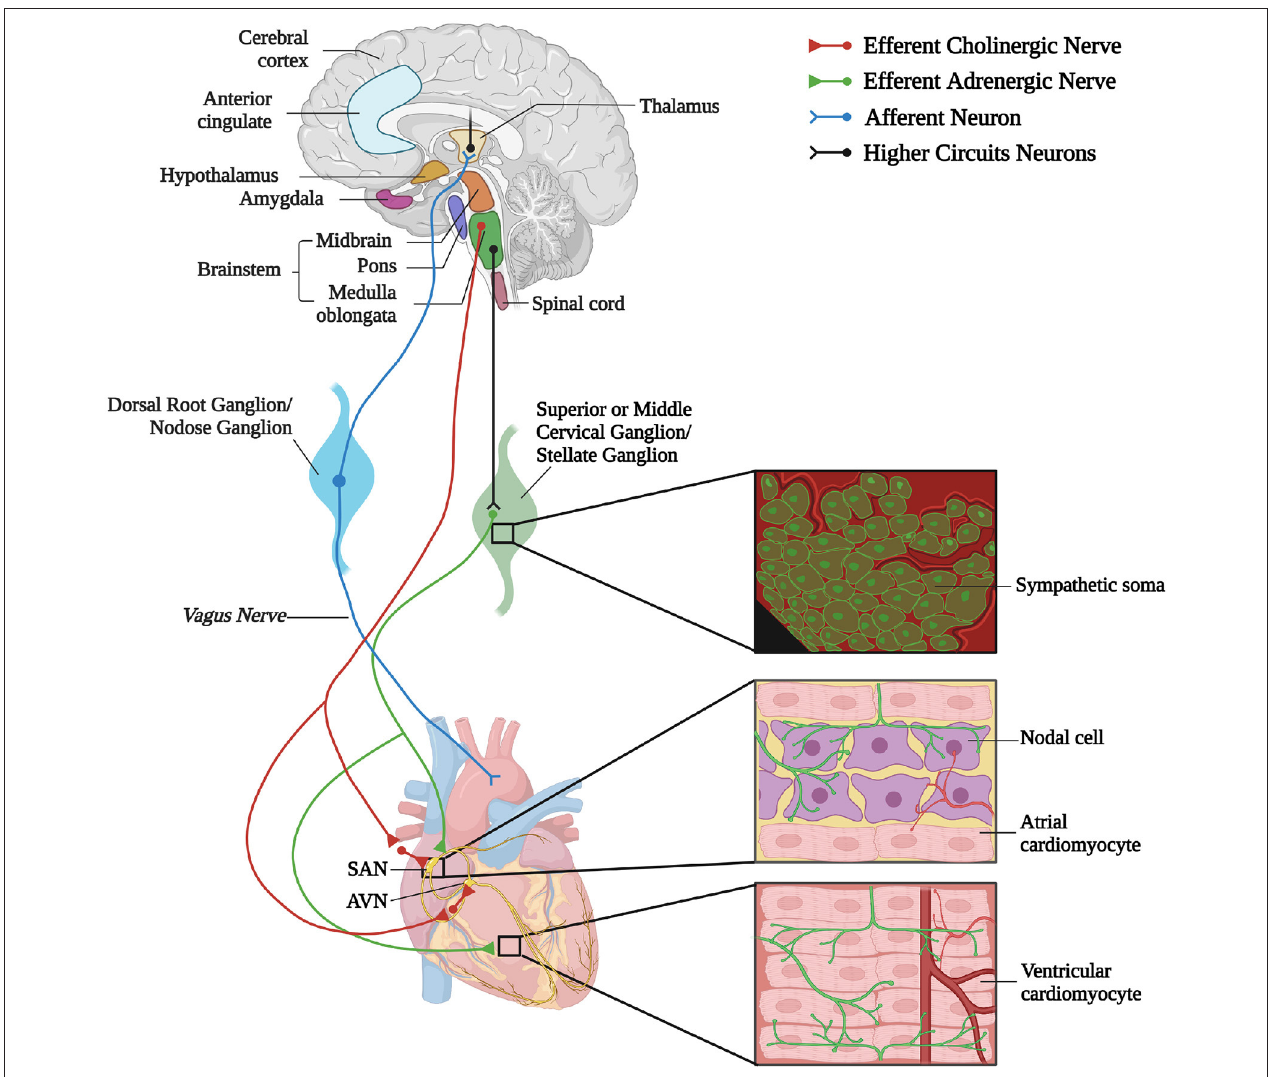
FIGURE 1 | The complex neuronal circuitries underlying bidirectional “brain–heart” connection. Schematic representation of the “brain–heart axis.” Different regions of the brain, belonging to the CAN process precise orders which are transmitted, through efferent preganglionic fibers, to both sympathetic (adrenergic) and parasympathetic (cholinergic) cardiac ganglia. While PSN processes mainly innervate the SAN and the AVN, SNs invade the conduction system and the working myocardium. The cardiac muscle is also innervated by intrinsic neurons (INS) and cardiac sensory neurons, whose cell bodies organize into the dorsal root ganglion and nodose ganglion, and their afferent fibers project to different areas of the brain (created with